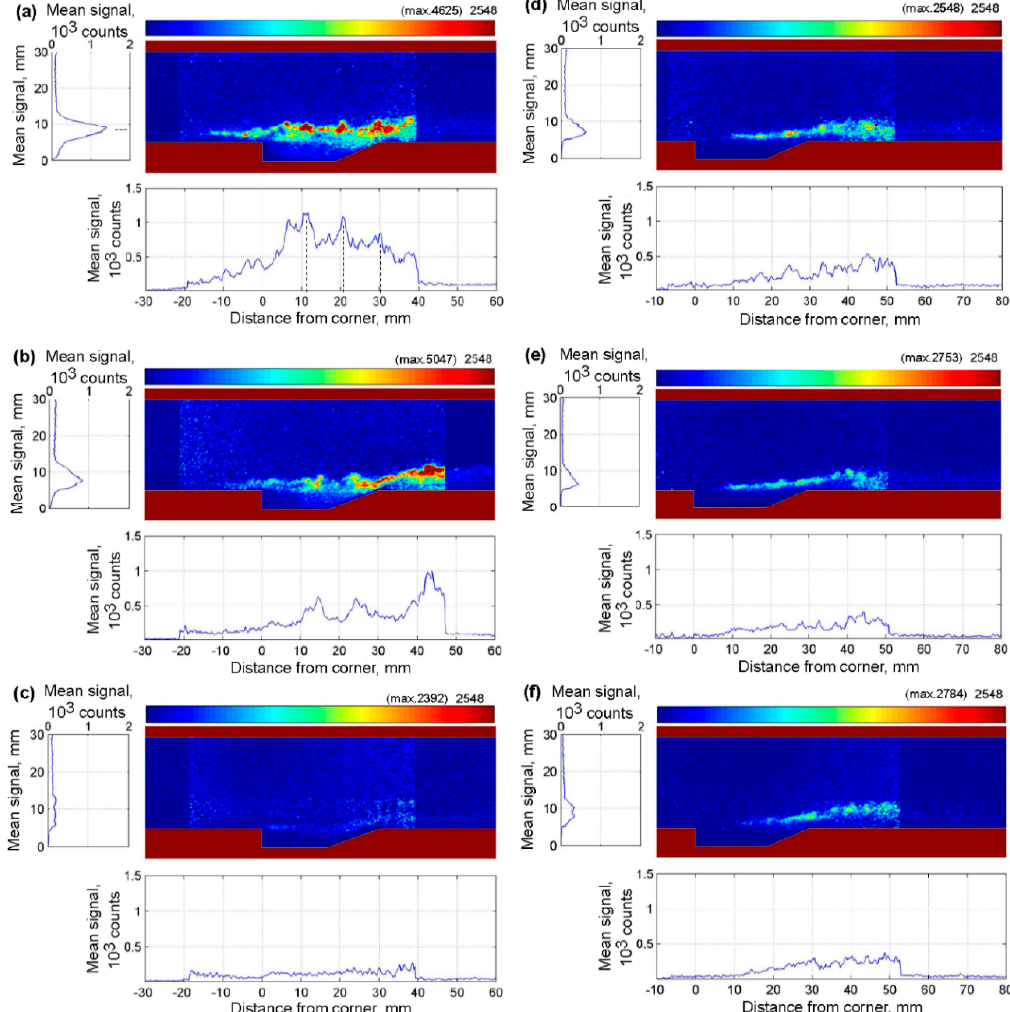
Figure 3. OH-PLIF images near the cavity Φ = 0.13: ( a ) angled injection, h 0 = 6.45 MJ / kg; ( b ) angled injection, h 0 = 5.16 MJ / kg; ( c ) angled injection, h 0 = 3.82 MJ / kg; ( d ) upstream injection, h 0 = 6.45 MJ / kg; ( e ) upstream injection, h 0 = 5.16 MJ / kg; ( f ) upstream injection, h 0 = 3.82 MJ / kg.